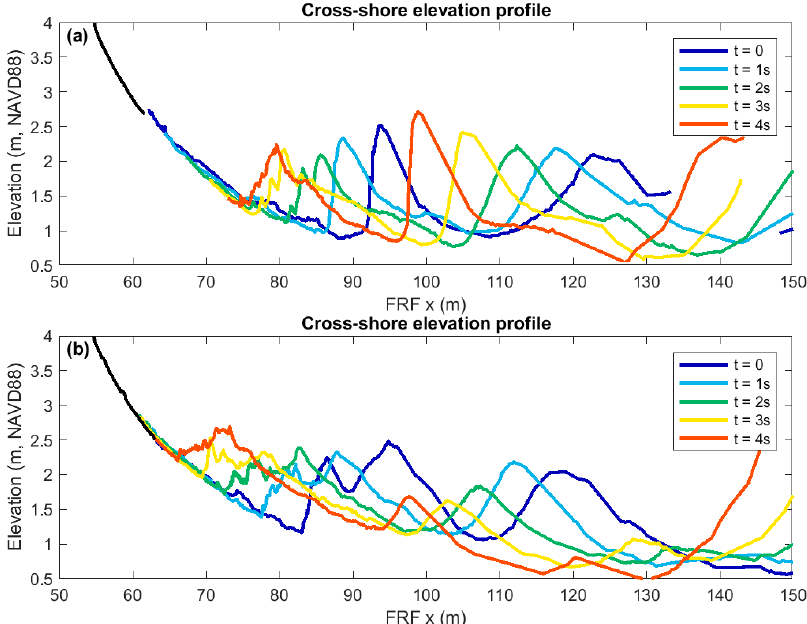
Figure 10. Cross-shore water surface elevation profiles over five-second time periods from ( a ) 4 October 2015 18:02 and ( b ) 4 October 2015 18:22 UTC (during Hurricane Joaquin).